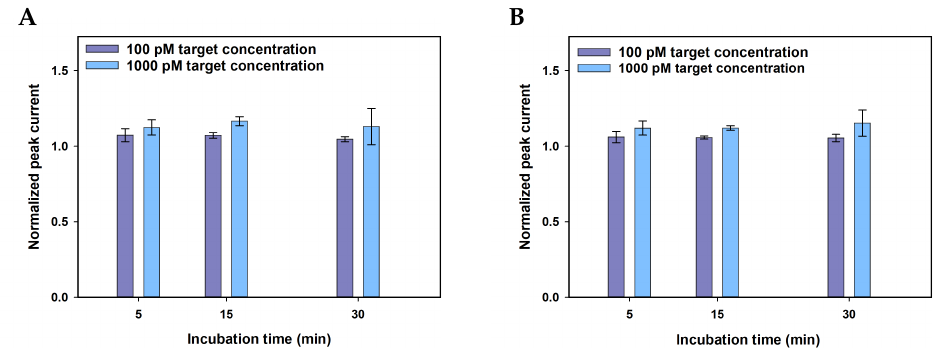
Figure A3. Detection of 100 (purple) and 1000 (blue) pM of the target gene with various bovine serum albumin (BSA) optimisation times (5, 15 and 30 min), using both CV ( A ) and DPV ( B ) techniques.